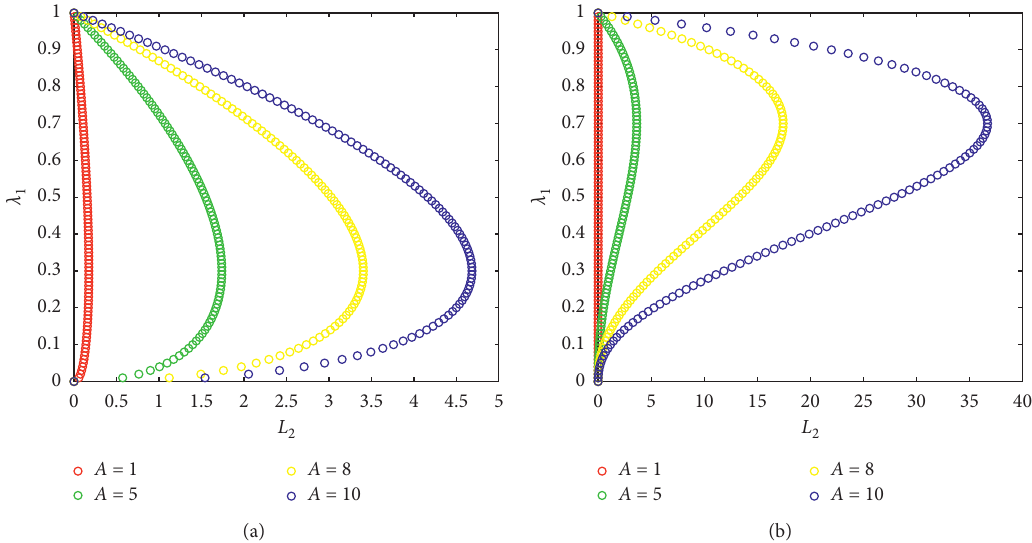
Figure 4: The influence mechanism of labor input level in medical institutions on the income distribution coefficient of pension institutions. (a) β < α . (b) β > α